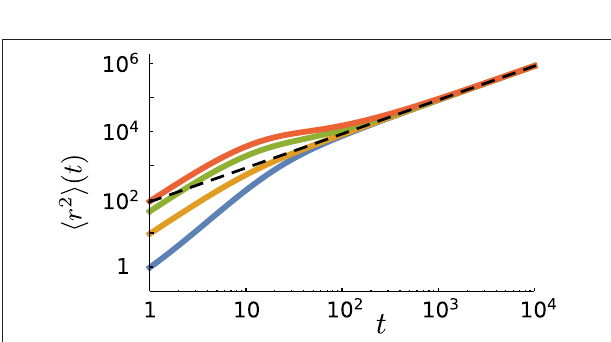
and f for v R = 10, v T = 1, 1 t = 1, and p = 0.9. R → T T → R